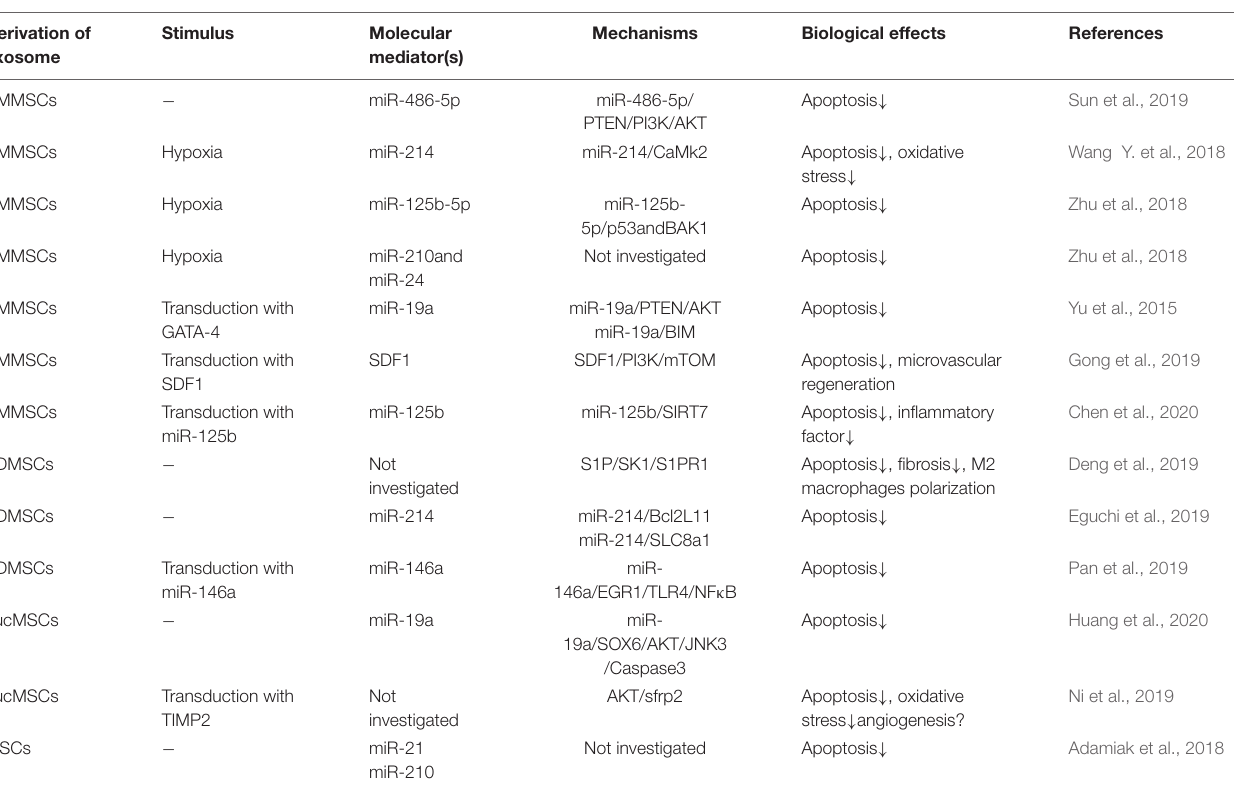
TABLE 1 | Mechanisms of exosomes from different cell sources against cardiomyocyte apoptosis. Derivation of